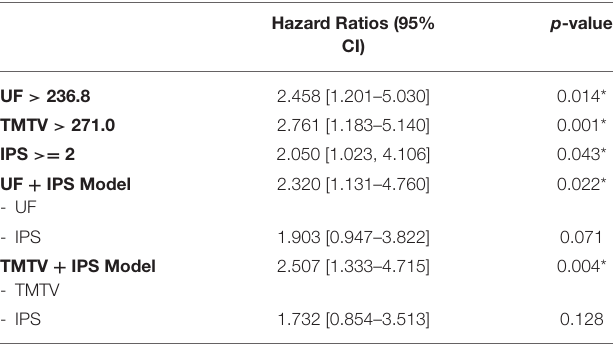
TABLE 3 | Univariate and bivariate analyses for Event-Free Survival (EFS) based on Cox model.